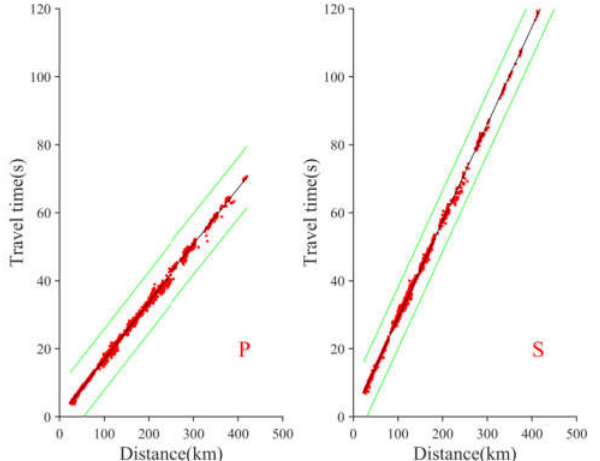
Figure 2. Observed (red) and predicted (black) travel times for the P (left) and S (right) phases. The green lines indicate the tolerance threshold (±9 s). Green line represents seismic phase screening boundary.